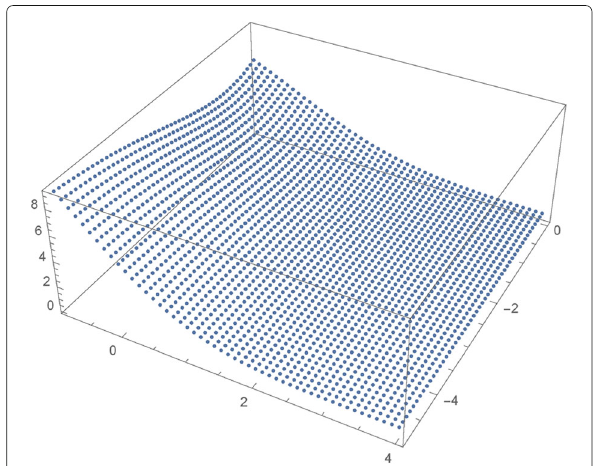
Fig. 16 Variance of the procurement cost V [ C ]